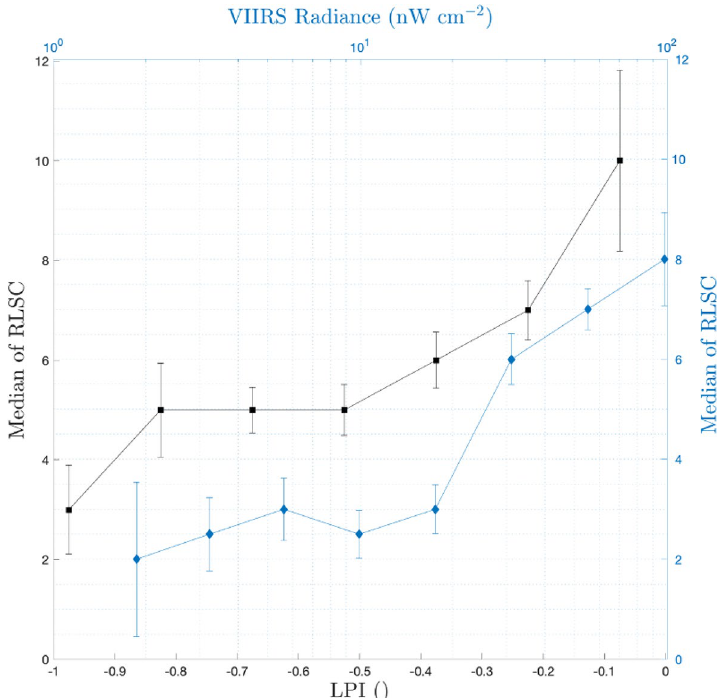
Figure 5. Correlation between RLSC and NTL (blue curve) and LPI (black curve). Dots and error-bars denote the median and standard deviation in each bin, respectively. Note the qualitatively similar behavior for the NTL and LPI statistics demonstrating the commonalities between LPI and NTL as tracers of human activity and landscape